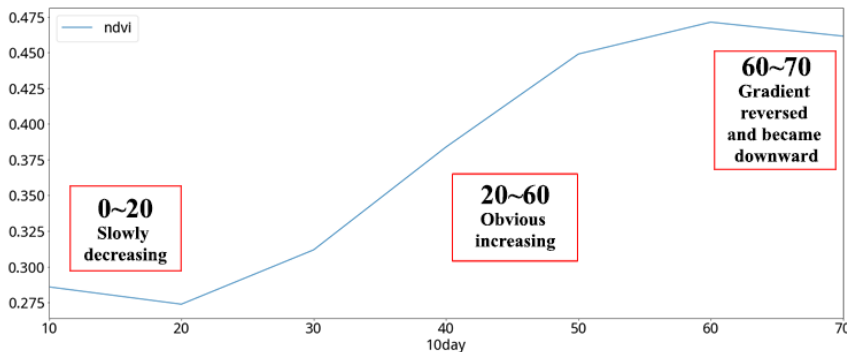
Figure 21. Cabbage growth stages vs. NDVI values. Table 7. Differences in individual features between two consecutive satellite images captured at the same location .